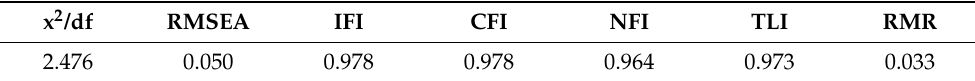
Table 9. Model Fit Indexes of Confirmatory Factor